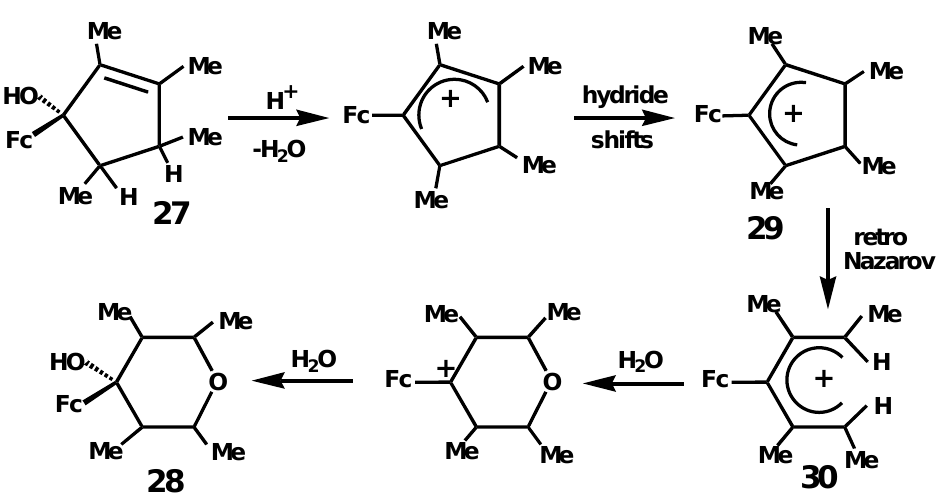
Scheme 7. Ferrocenyl-mediated retro-Nazarov ring-opening to form a hydroxytetramethyl- tetrahydropyran.